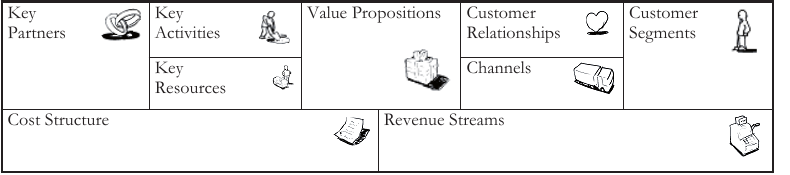
Fig. 2 - The visualization tool Canvas by Osterwalder & Pigneur